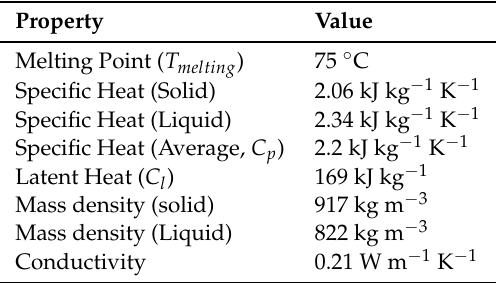
Table 4. Thermal properties of paraffin 70–75 are given